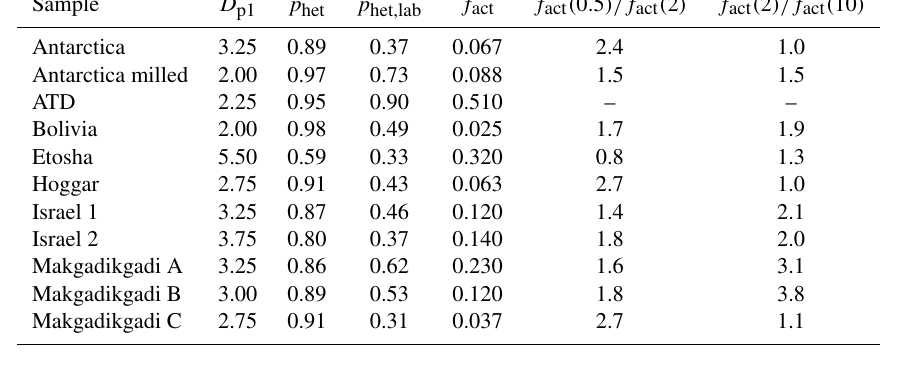
Table 2. Evaluation of active particle fractions ( f act ) in natural dust samples evaluated for 2wt% suspensions, with the exception of ATD (5wt%). D p1 : droplet diameter with on average 1 particle inside (µm); p het : calculated heterogeneously frozen water volume frac- tion assuming that droplets containing particles froze heterogeneously; p het,lab : measured heterogeneously frozen water volume fraction; f act ( 0 . 5 )/f act ( 2 ) : ratio of f act determined for 0.5 and 2wt% suspensions; f act ( 2 )/f act ( 10 ) : ratio of f act determined for 2 and 10wt% suspensions.